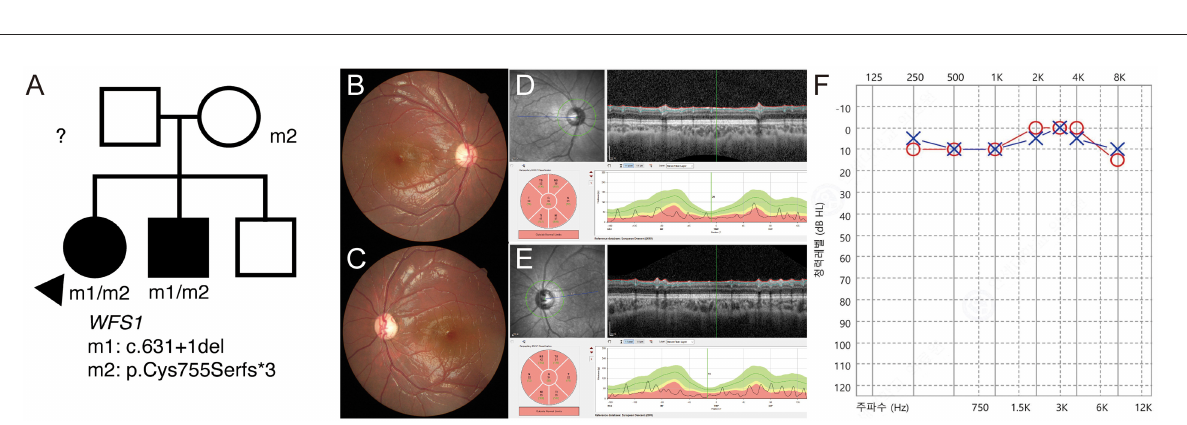
FIGURE4 (P17) Targeted next-generation sequencing identify WFS1 variants in optic atrophy with diabetic ketoacidosis. Clinical diagnosis before genetic testing is Wolfram syndrome. Best corrected visual acuity is 1.40 logMAR in both eyes. (A) The segregation analysis shows compound heterozygous c.631 + 1del/c.2262_2263del:p.(Cys755Serfs*3) variants. These variants are also detected in her brother. The paternal sample is not available. (B,C) Fundus photographs showing generalized diffuse optic atrophy. (D,E) The optical coherence tomography revealing generalized retinal nerve thinning. (F) Audiometry is normal at the age of 7 years.